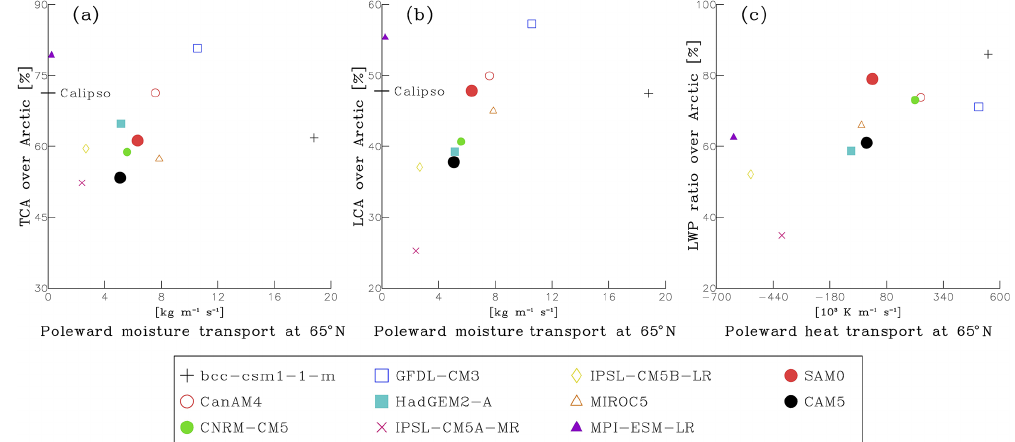
Figure 8. Scatter plots of the annual-mean poleward fluxes of moisture and heat integrated over the vertical layers (1000–7000hPa) at 65 ◦ N, cloud fractions, and LWP ratio averaged over the Arctic, obtained from various AMIP simulations of CMIP5 models, CAM5, and SAM0. The black lines in (a) and (b) denote the observed TCA and LCA, respectively, obtained from CALIPSO-GOCCP